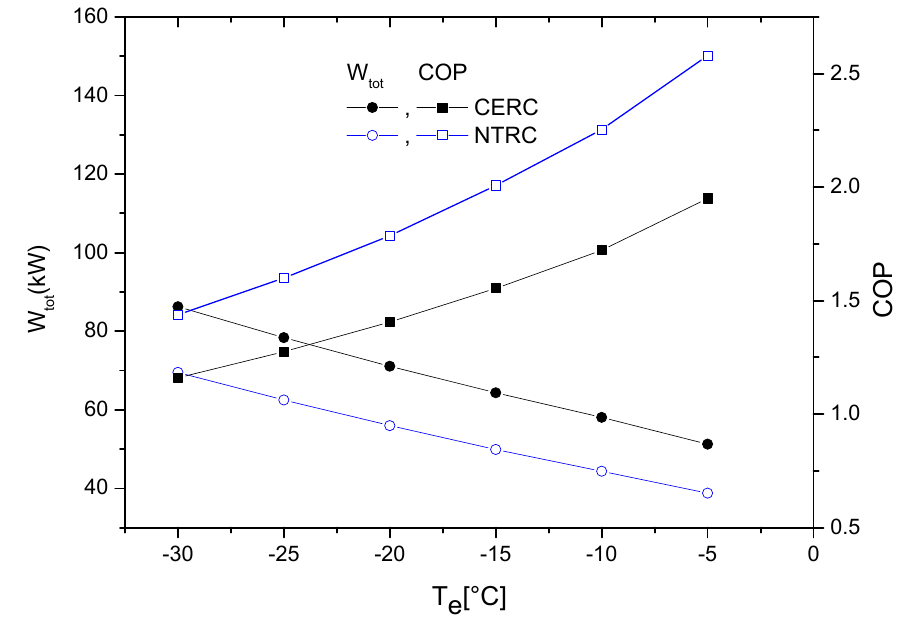
Figure 11. The e ff ect of T e on the cycles’ COP and W net . Figure 11. The effect of T e on the cycles’ COP and W net .